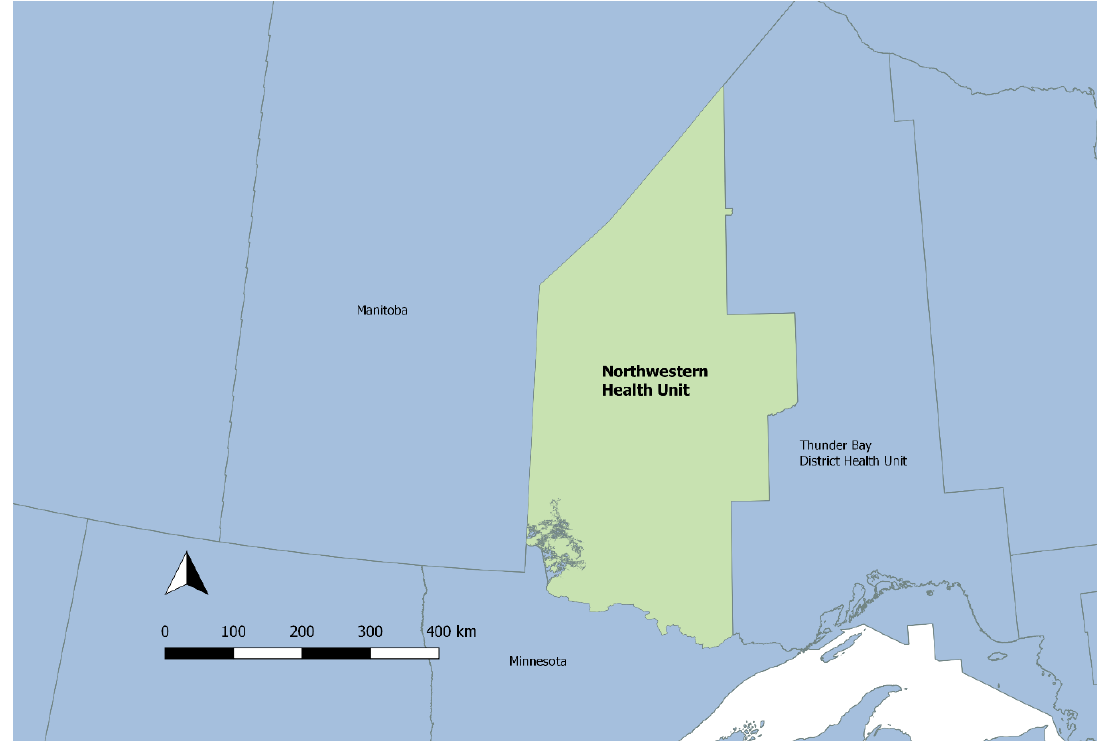
Figure 1. Northwestern Health Unit (NWHU) catchment area map.